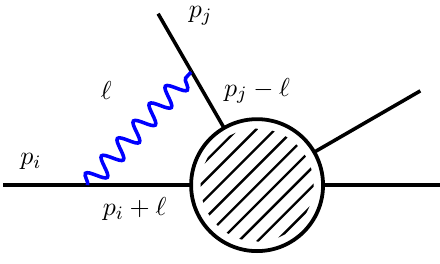
Figure 14 . Infrared divergence in Supergravity